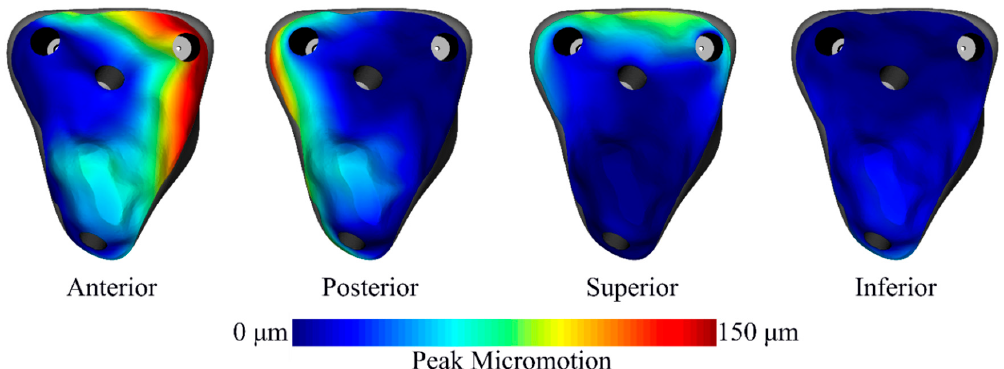
Figure 6. Back view of the implant. Peak micromotion map at the bone–implant interface for all the loading directions.